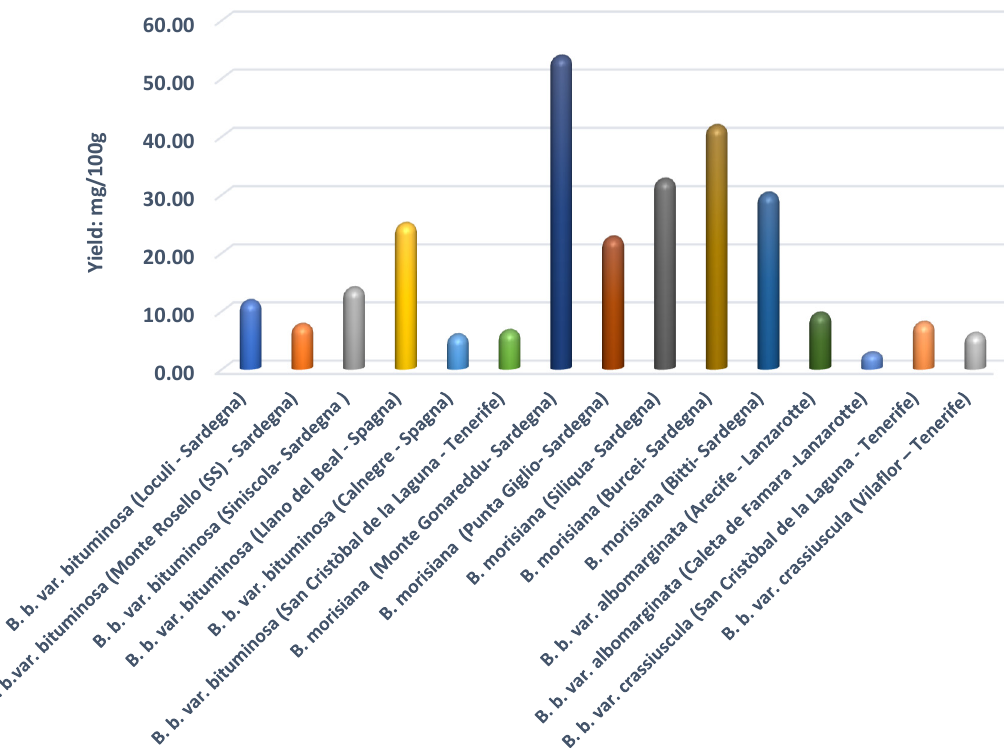
Figure 5. Essential oil yield (mg/100 g) of Bituminaria species and varieties.